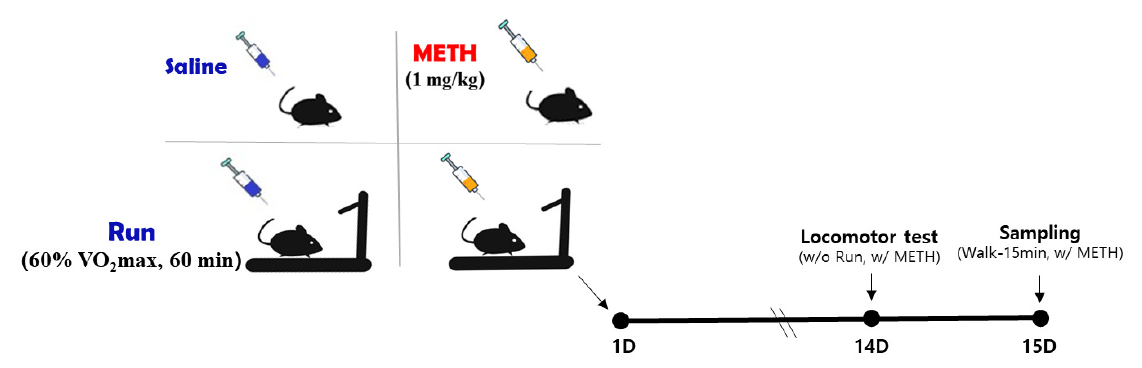
Figure 1. Schematic view of the experimental design. METH, methamphetamine; D, day; w/o, without; w/, with.